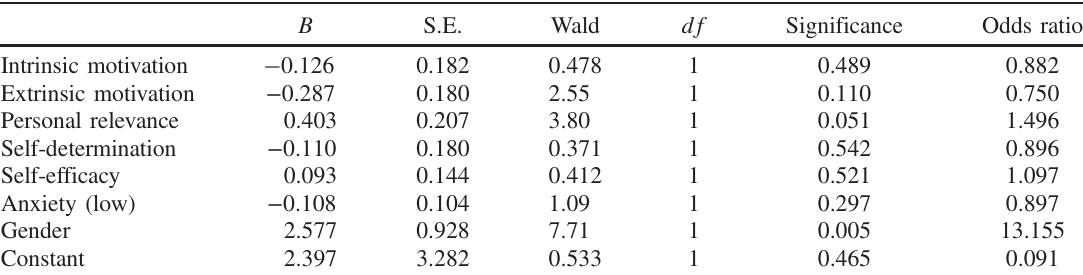
TABLE IX. Motivation impact on graduate student career choice (academic or